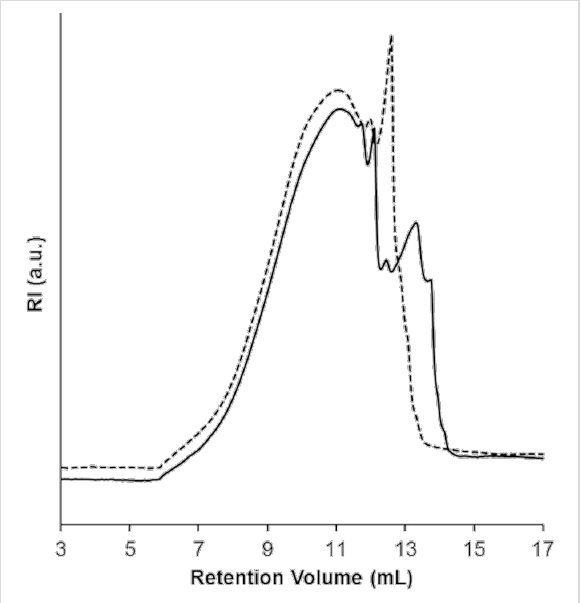
Figure 2: SEC curves of the β -CD-based polymer before (solid line) and after ultrafiltration with cut-off size of 30000 Da (dashed line).